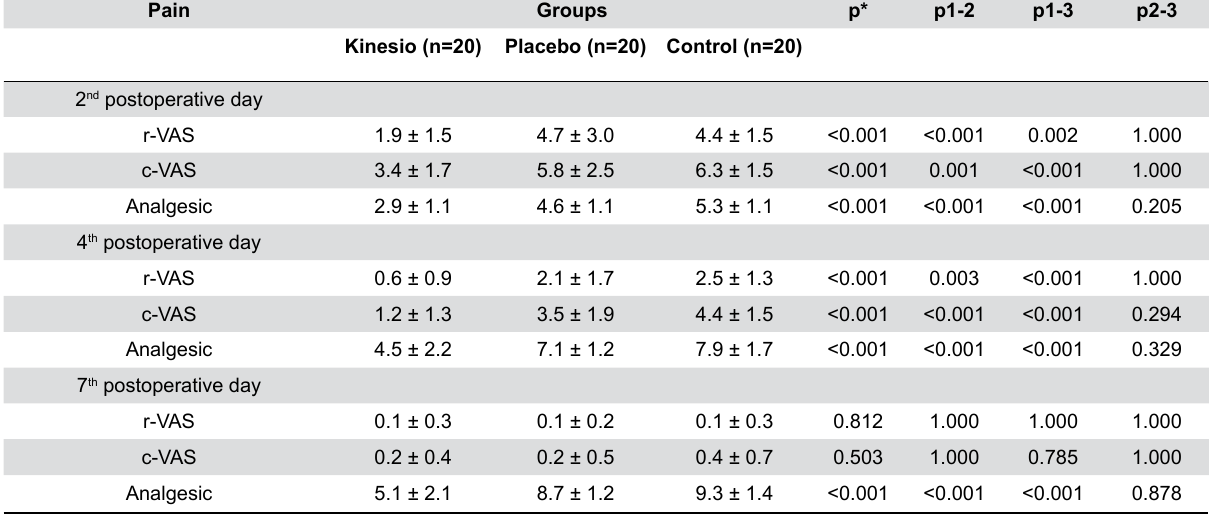
Table 3- Comparison of pain parameters (r-VAS and c-VAS values, and total number of analgesic tablets taken) among the three groups. All values are shown as mean ± SD